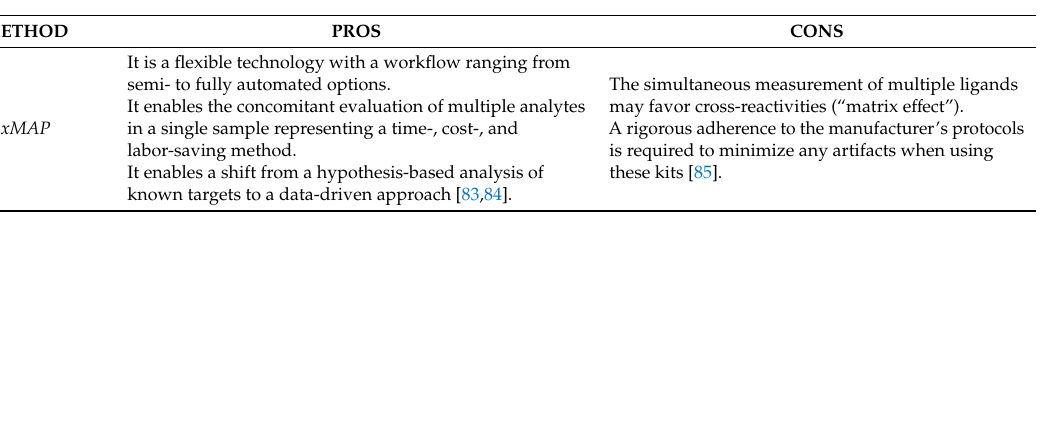
Table 1. Key points of ultrasensitive techniques for the detection of putative blood biomarkers for